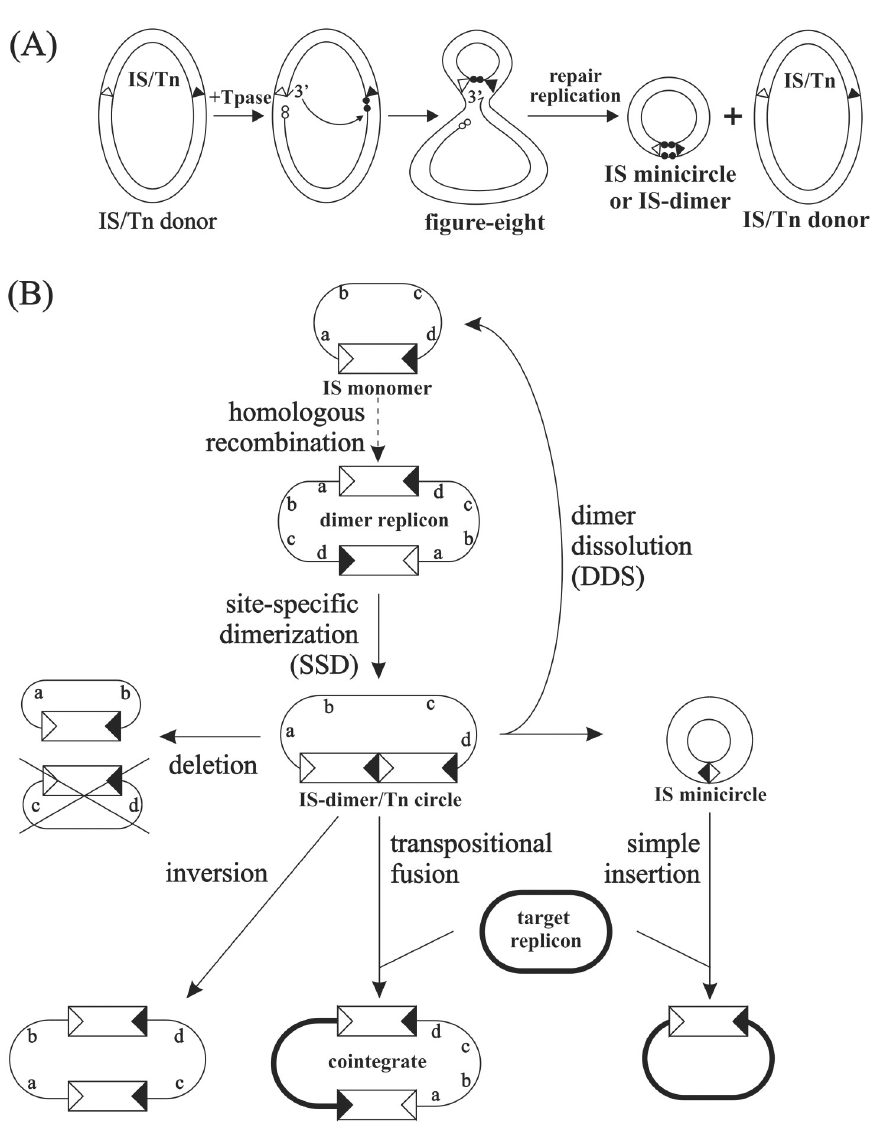
Fig 1. Schematic model of IS 30 transposition. (A) Molecular model of the formation of IS minicircles and IS-dimers (IS 30 ) 2 . The IS element is delimited by open (IRL) and filled (IRR) triangles representing the 26-bp left and right inverted repeats, respectively. The two bases adjacent to the Tpase-generated nick next to the donor end are indicated by open circles. The two bases bordering the targeted end at the same strand are shown as filled circles. The free 3’OH ends (3’) are indicated. Note that the same reaction produces a Tn-circle that is formally equivalent to the (IS 30 ) 2 dimer, if the IRs of two IS 30 copies are joined. (B) A mechanistic model of the two-step copy-out-paste-in transposition of IS 30 . The IS elements are shown as open boxes delimited by IRL and IRR. Thin line, donor replicon; thick line, target replicon. Solid and dashed arrows indicate transposition and non-transposition events, respectively. Dimer replicon may arise by homologous recombination. Letters show the order of genes and indicate inversion or deletion on the donor replicon (intramolecular transposition). One of the deletion products is not detectable if it cannot replicate (crossed). IS minicircle is frequently produced from a dimer via DDS, but any IS copy can also produce circular element via a SSD-like